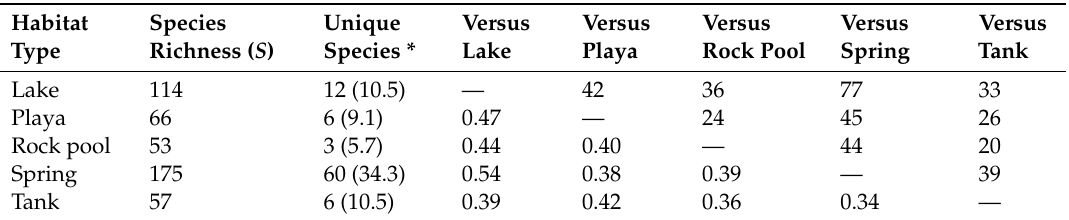
Table 1. Species richness, unique species, and Sorensen’s Index (below diagonal) and number of shared species (above diagonal) of rotifers from five selected habitat types in the Chihuahuan Desert. Habitat Type